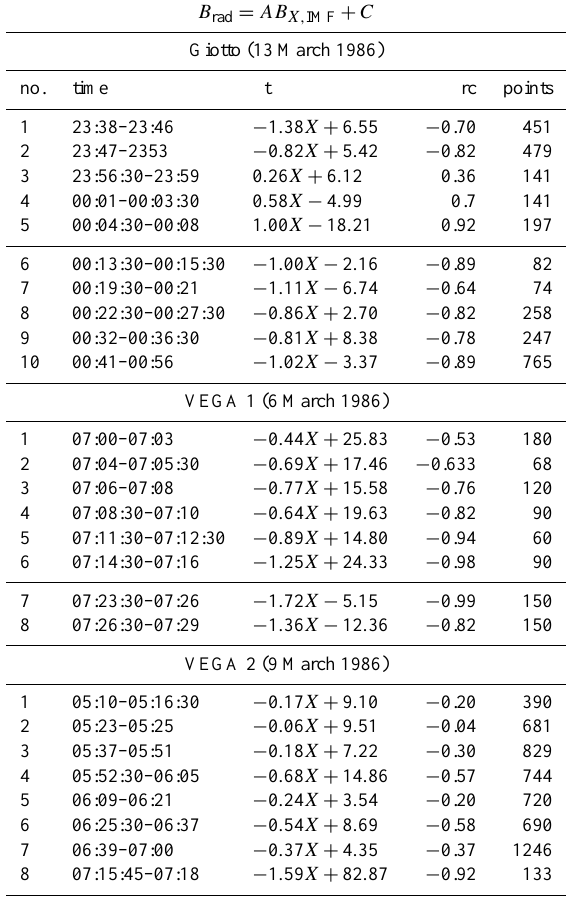
Table 2. Magnetic field line draping fit